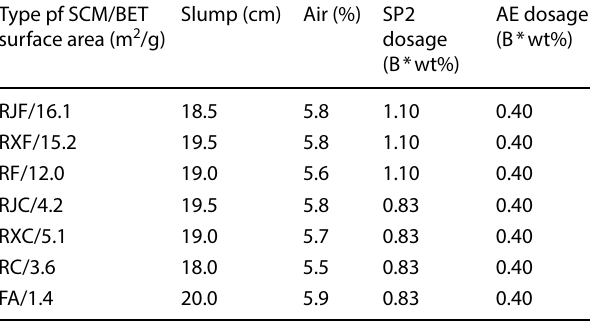
Table 8 Fresh properties and chemical admixture dosage of Series II